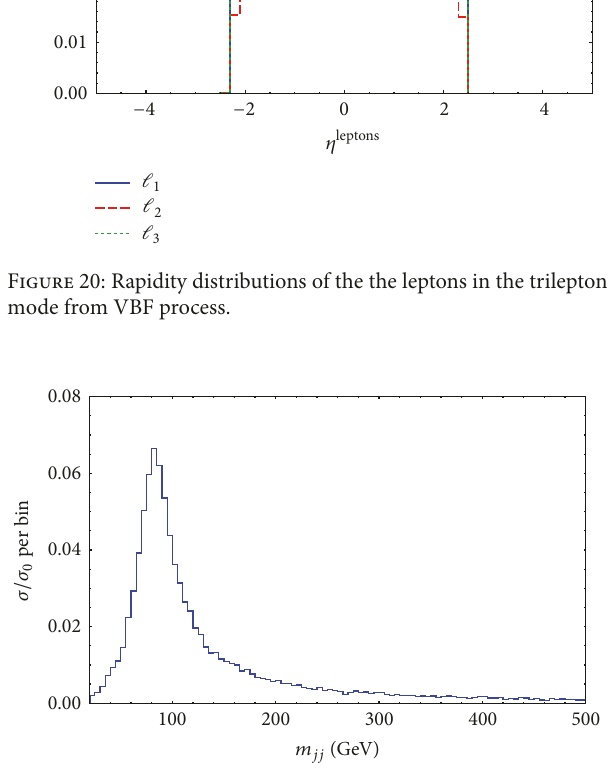
Figure 21: Invariant mass distribution of the two-jet system (𝑚 𝑗𝑗 ) from the ℓ + MET + 2𝑗 + 𝑋 final state from the pp → 𝑁 ] 𝑋 process. The two-jet system shows a peak around the 𝑊 mass (𝑚 𝑊 ) .